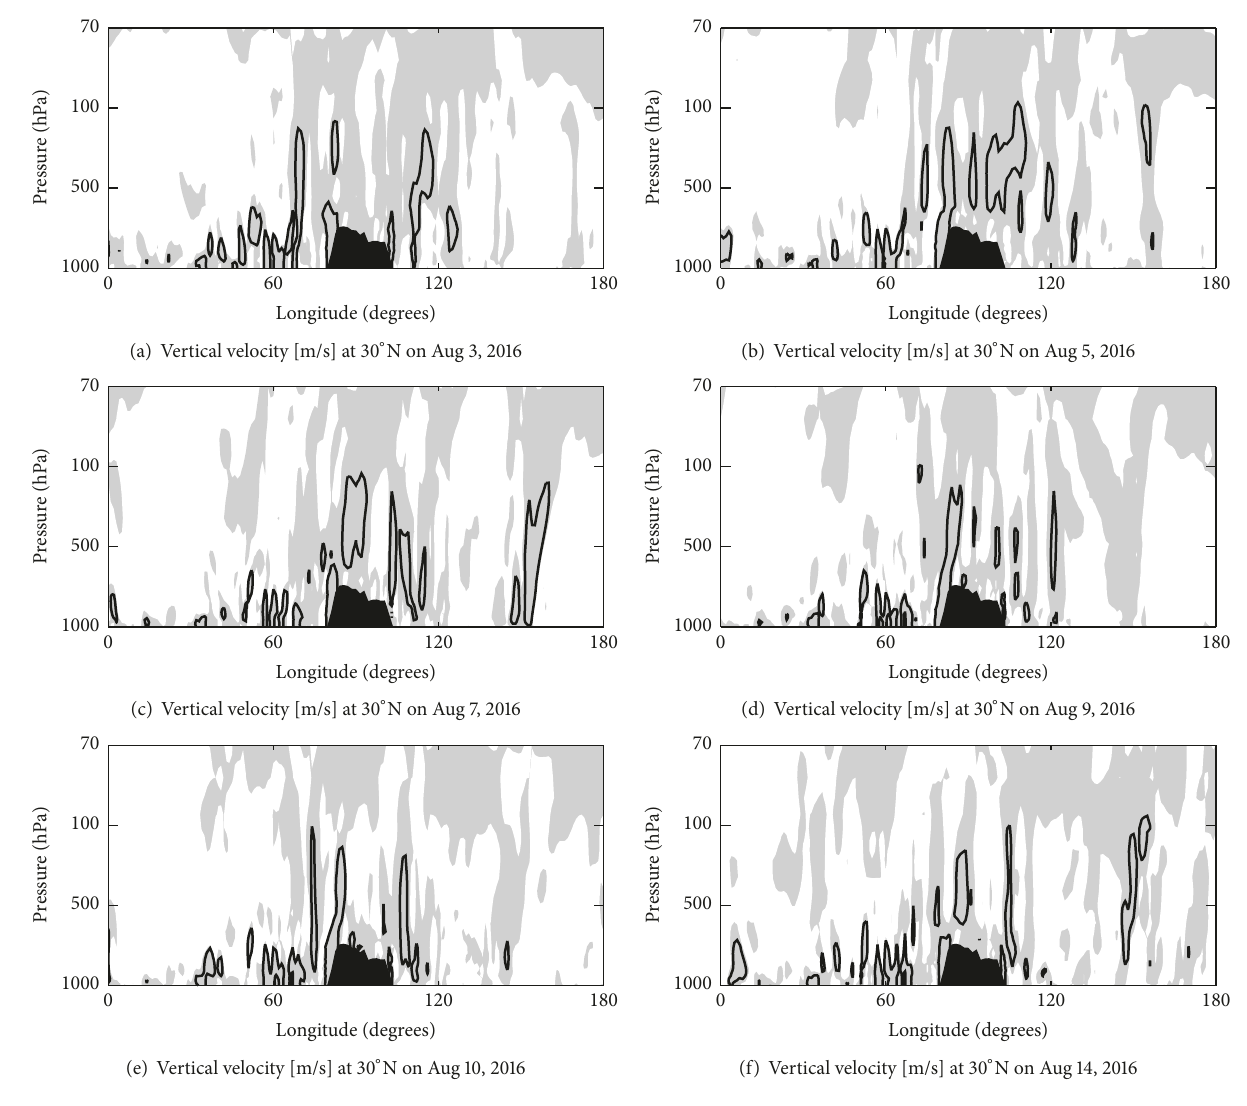
Figure 8: The same as Figure 7, but along 30 ∘ N. Black shading indicates